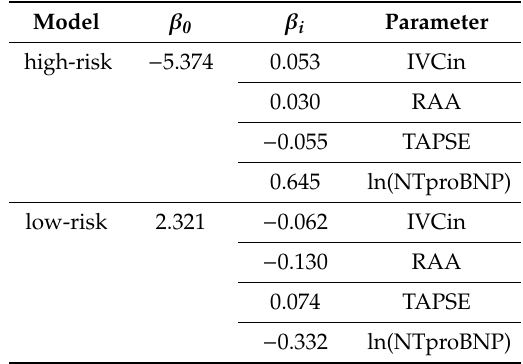
Table 5. Results of logistic regression